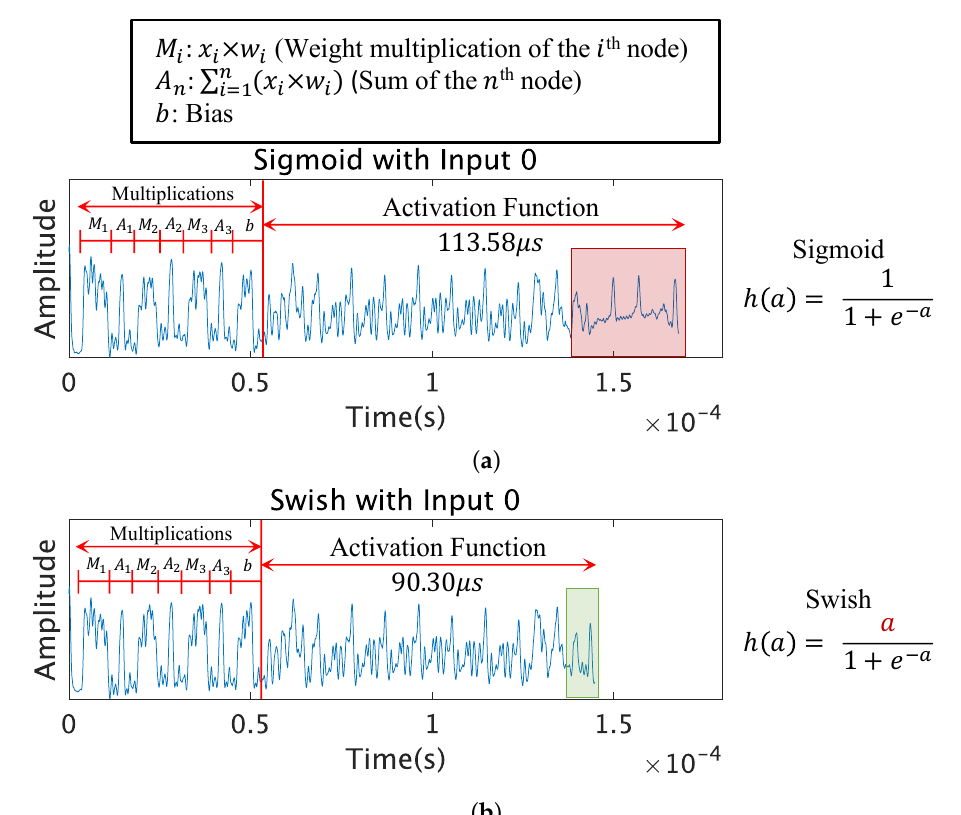
Figure 5. Comparison of the Patterns of Sigmoid and Swish Functions for Input 0. ( a ) Sigmoid Function. ( b ) Swish Function.